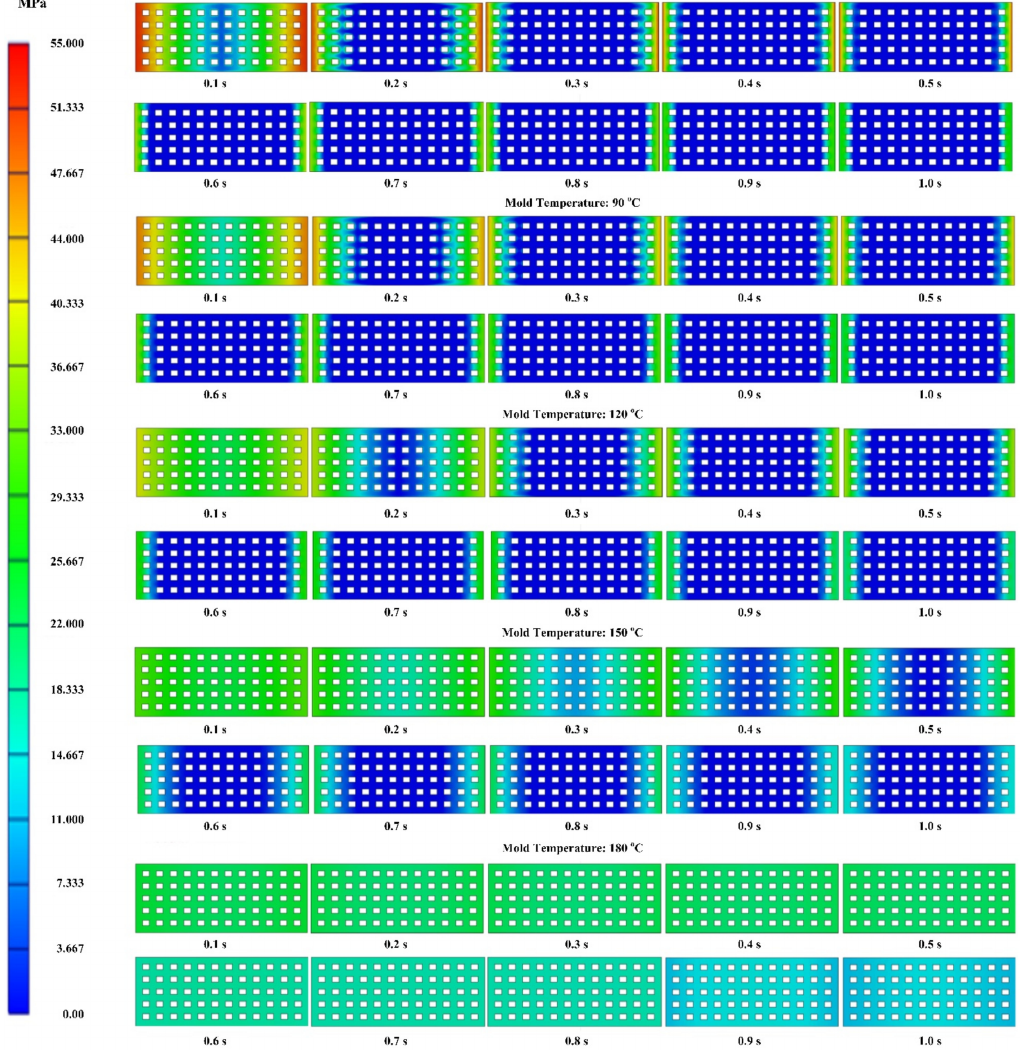
Figure 17. Pressure distribution at the weld line area with part thickness of 0.4 mm under di ff erent mold temperatures using PA6 material.